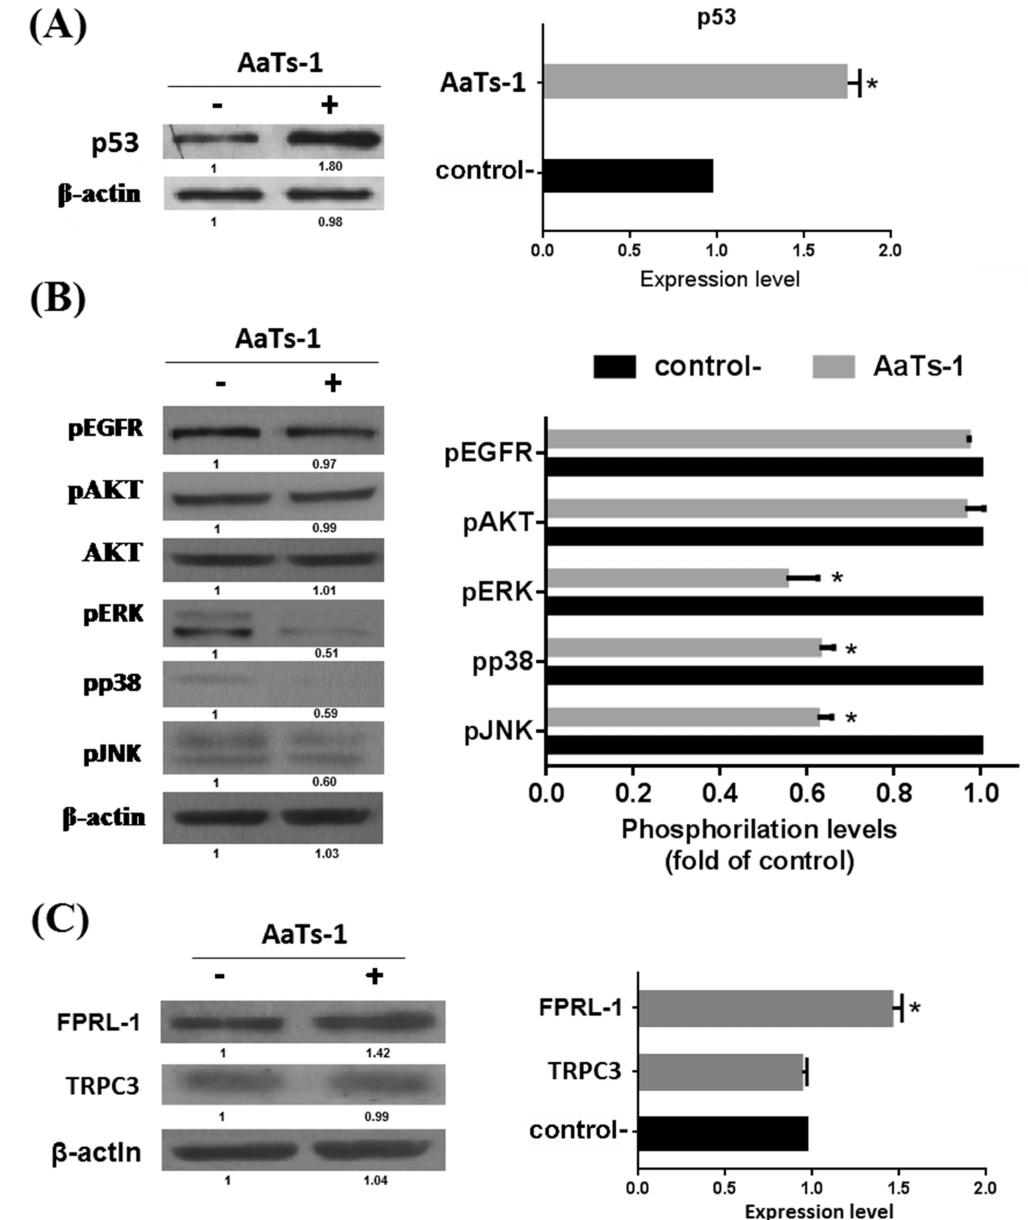
Figure 5. Analysis of cellular effectors targeted by AaTs-1 in U87 cells. Western blot analysis realized with U87 cells lysates treated or not treated (negative control) with AaTs-1 (0.56 mM) using the indicated antibodies ( left ). Tests were done on duplicate minimum. Densitometric representation of the Western blot results ( right ). The graph bars show relative protein expression level normalized to control. Quantitative assay differentiated by Image-J software. Mean, SD. * p < 0.05, significantly different from control. ( A ) Analysis of the expression level of p53. ( B ) Analysis of the phosphorylation levels of EGFR; AKT, ERK, p38 and JNK. ( C ) Effect of AaTs-1 on FPRL-1 and TRPC3 protein expression in U87